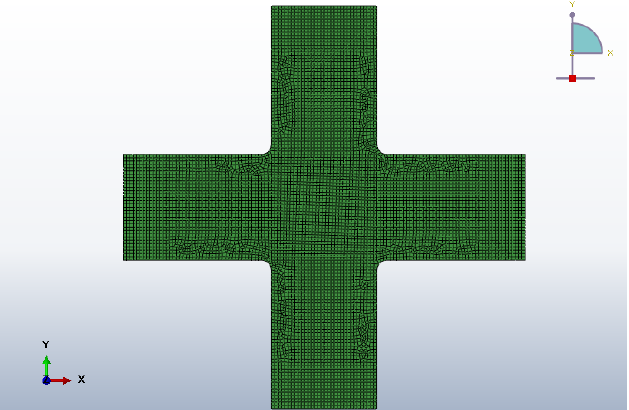
Figure 11. The finite element model.